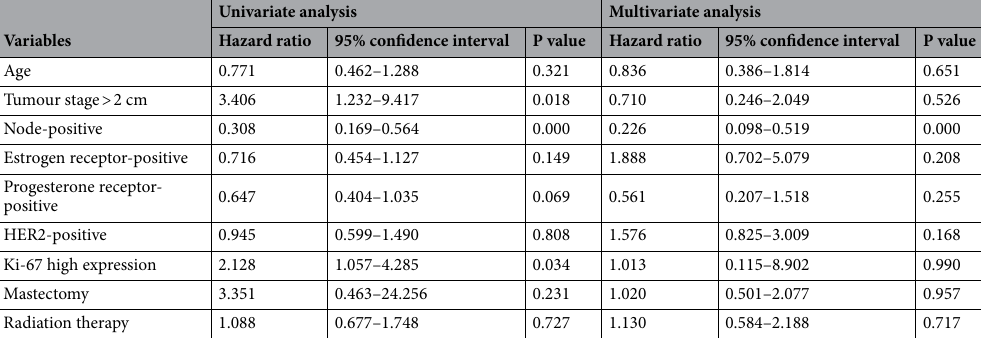
Table 3. Cox regression analysis for overall survival in southern China.